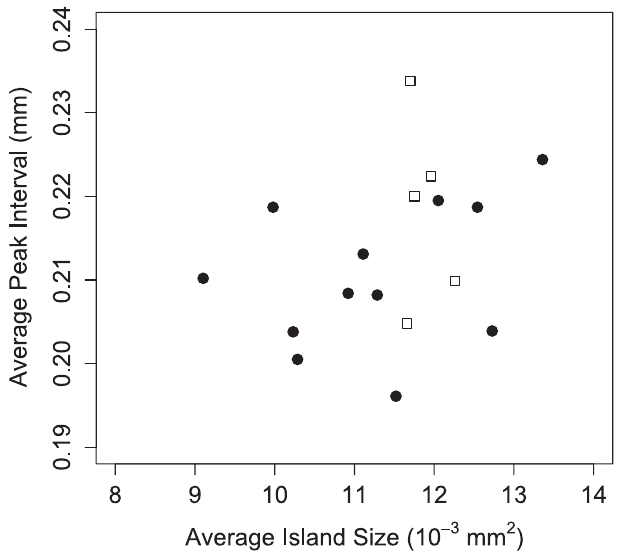
Figure 4. Average Peak Interval versus Average Island Size for Oscillatory Regime Averages are shown for 12 experimental (circle) and five simulation (square) points using parameter values in Table 2 with different random initial conditions. All simulations were run for 3,000 iterations with periodic boundary conditions.